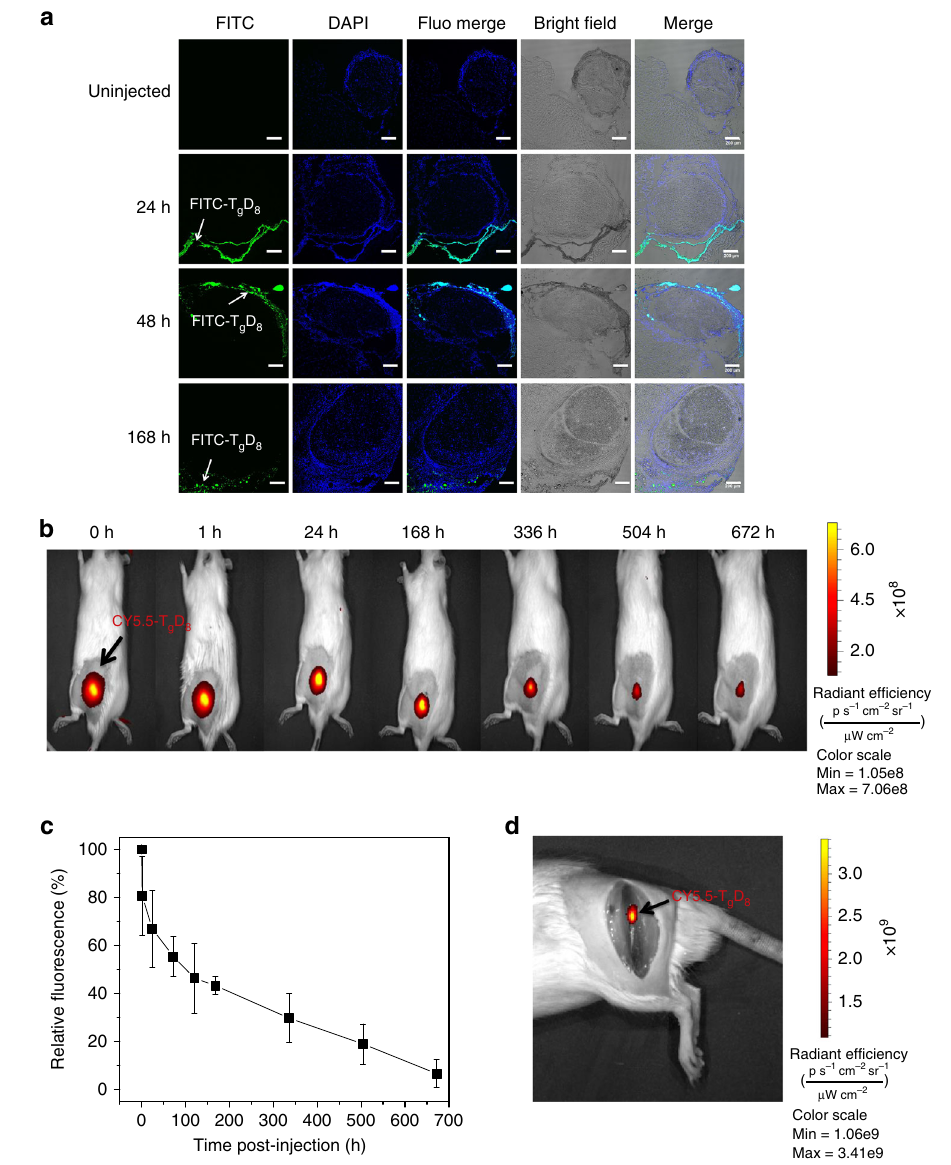
Fig. 5 Retention in tissue of fl uorescently labeled T g D 8 injected at the sciatic nerve. a Representative fl uorescent confocal photomicrographs 24, 48, and 168 h after sciatic nerve injection of 25 mg of FITC – T g D 8 in 0.5 mL of PEG200. Green: FITC – T g D 8 ; blue: cell nuclei (stained with DAPI). Scale bars, 200 µ m. b Whole body imaging of fl uorescence injection of 25 mg of CY5.5 – T g D 8 in 0.5 mL of PEG200. Fluorescence intensity is represented as radiant ef fi ciency. c Quanti fi cation of data in panel ( b ), Data are means ± SD ( n = 4). d Representative photographs of dissection of injection site 24 h after injection. Data are representative of 4 animals in each